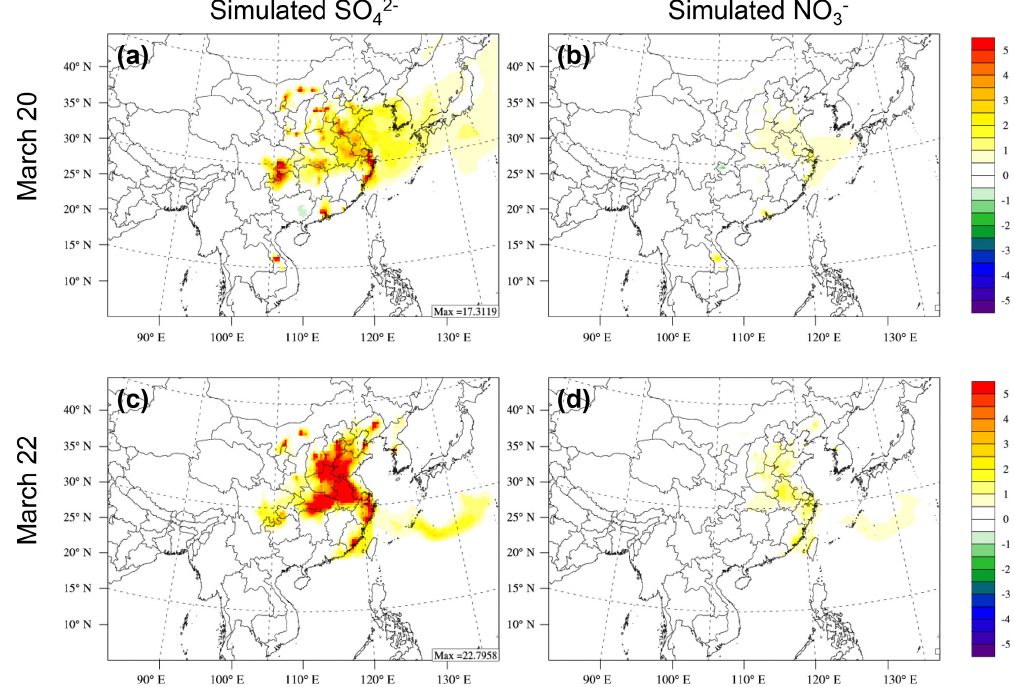
Figure 10. Simulated SO 2 −